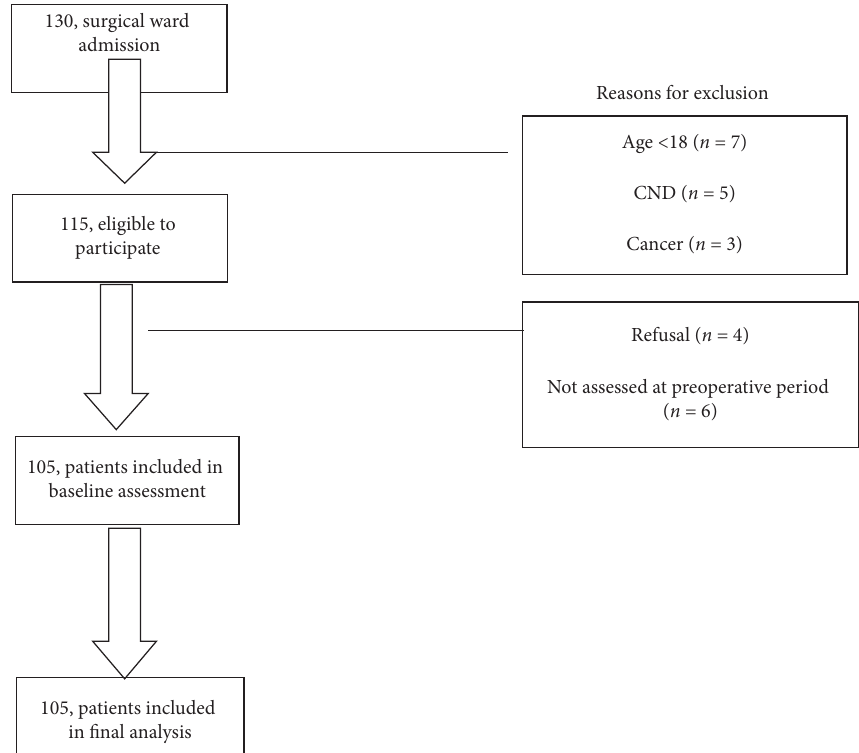
Figure 1: Study participant’s flow chart in hospitals at Wolaita zone, southern Ethiopia, 2016. CND: chronic noncommunicable